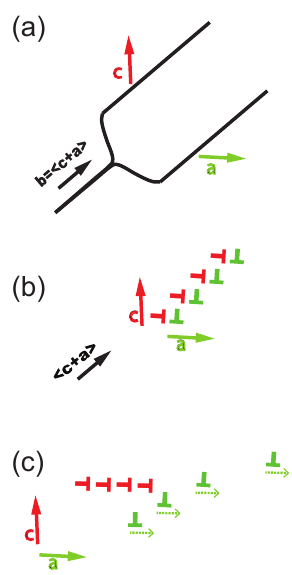
Figure 6. Schematic drawing of the dissociation of screw disloca- c a tion b as one possibility to form a P = (cid:104) + (cid:105) c a ary; (a) screw dislocation extending into an edge dislocation (cid:104) + (cid:105) dipole (after Hondoh, 2006). (b) Dissociation into b a dislocations; (c) b dislocations glide away, and b = (cid:104) (cid:105) cations are left behind to form a P-type